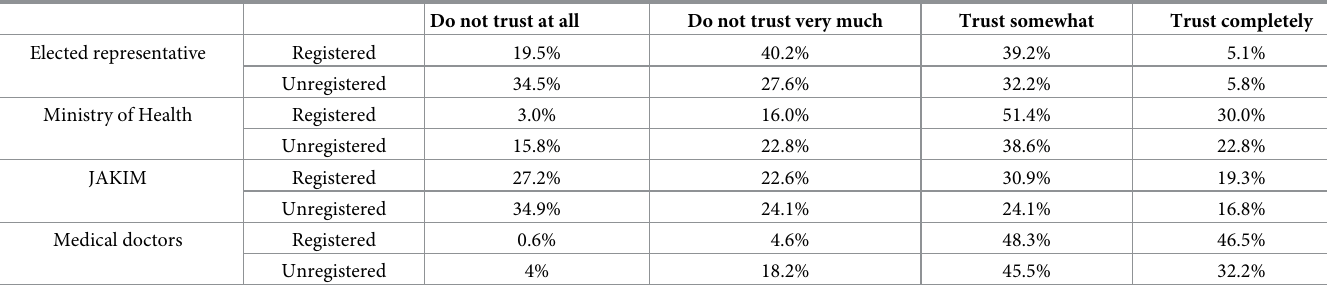
Table 5 summarized respondents’ trust levels towards government actors based on their vaccination registration status. Their answers were categorised into a 4-level Likert scale, namely; i) “don’t trust at all”, ii)“do not trust very much”, iii) “trust somewhat”, and iv) “trust completely” . These actors were selected as they had the ability to influence vaccination take-up in the population through effective delivery systems (Ministry of Health (MOH) and medical Table 5. Levels of trust towards policy actors by vaccination registration status. Do not trust at all Do not trust very much Trust